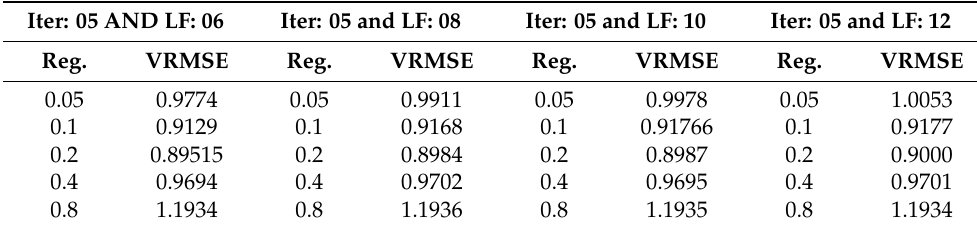
Table 5. The number of iterations with regularization with different RMSE parameter values.